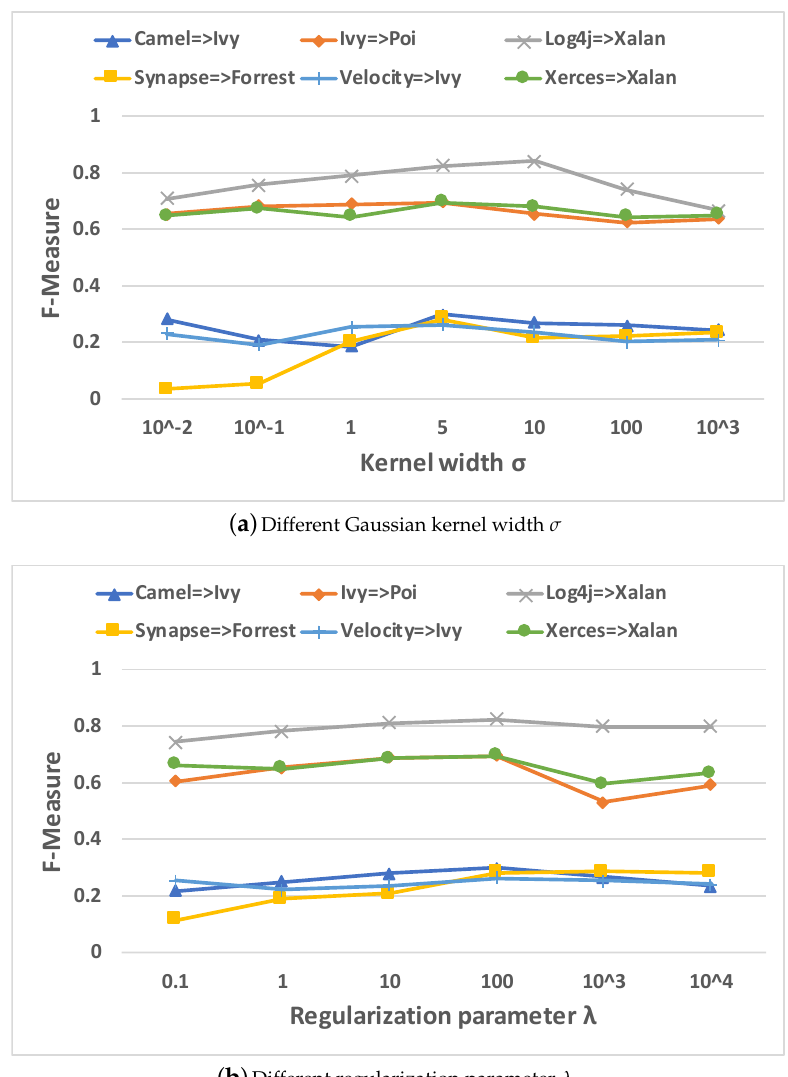
Figure 5. Performance of TCNN under different parameter